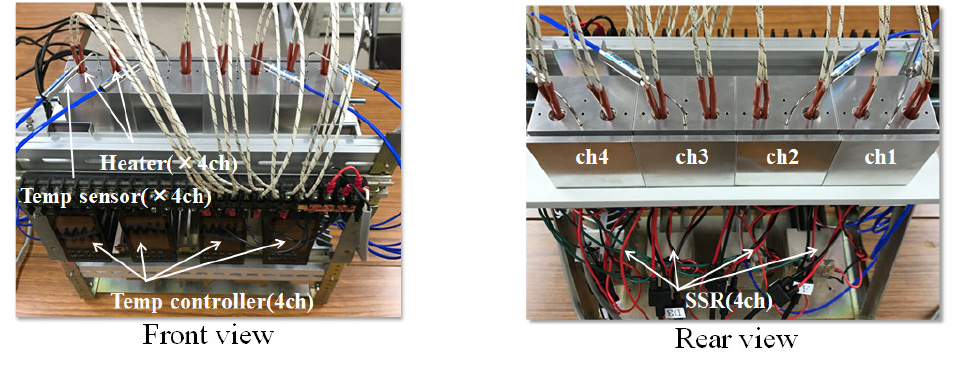
Figure 6. Experimental